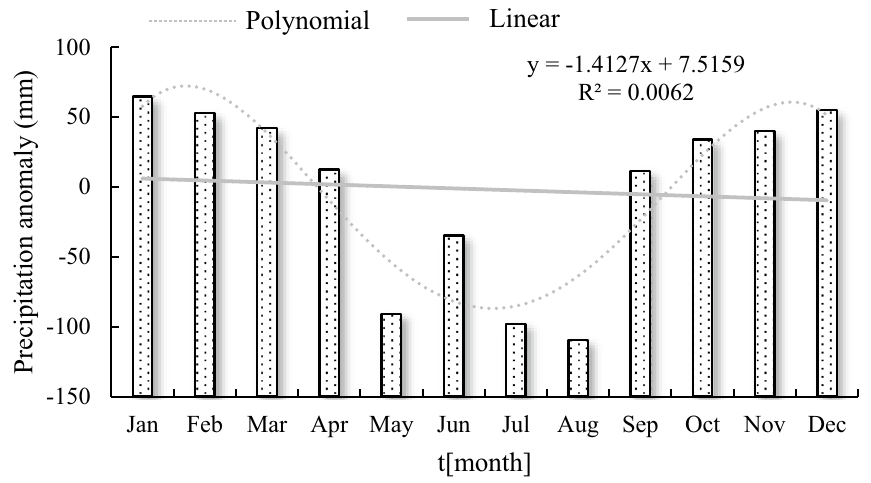
Figure 4. Monthly change trend of precipitation anomaly in Hancang River Basin.